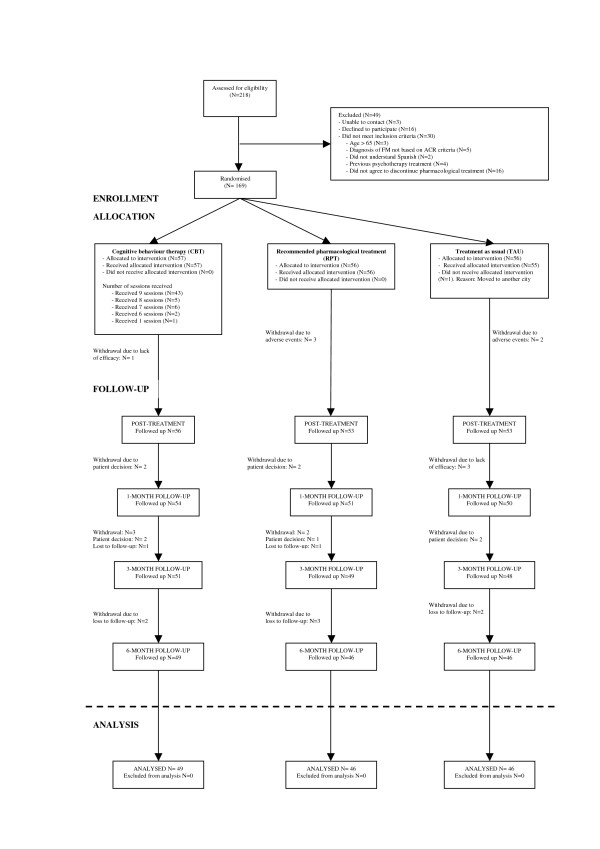
Flowchart of the study.